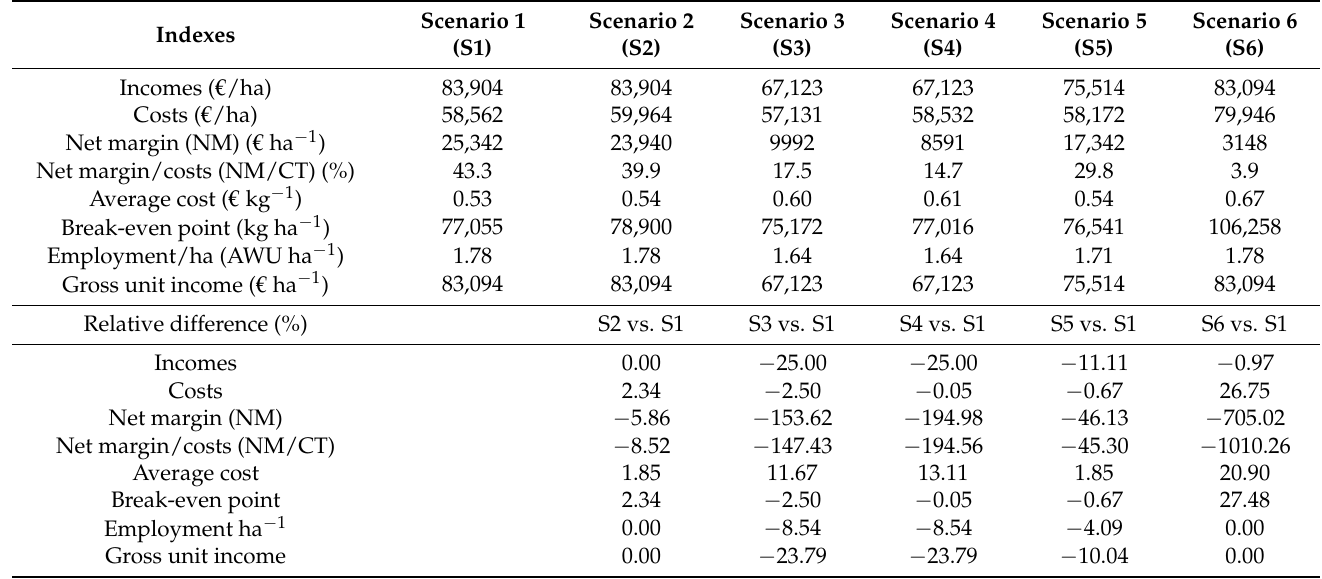
Table 5. Values of the economic indicators in the scenarios analyzed (Table 3) and the relative difference (RD) between the current scenario (S1) and those proposed